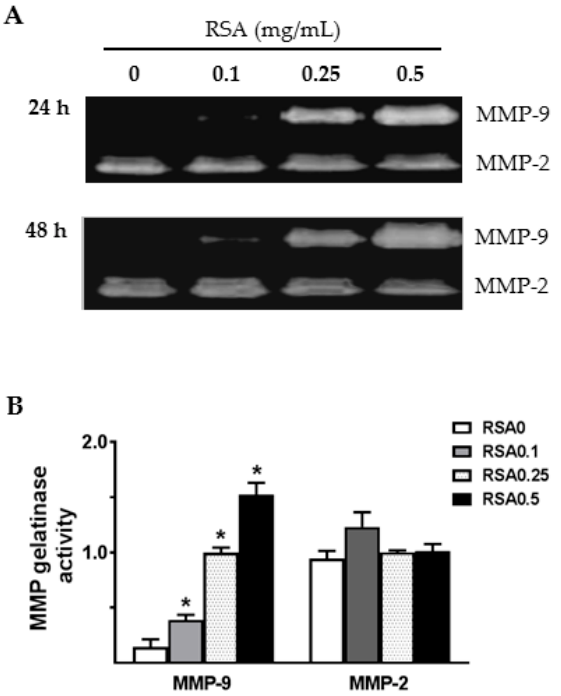
Figure 7. MMP-9 activity was increased in culture supernatants of primary rat TECs upon albumin stimulation. Gelatin zymography analysis confirms a dose-dependent increase in MMP- 9 activity in the culture supernatants when the cells were incubated with rat serum albumin (RSA, 0.1–0.5 mg/mL) for 24 h ( A ) or 48 h ( A , B ), whereas MMP-2 activity was not altered. Values are mean ± SEM. n = 4; * p < 0.05 vs. untreated control group.